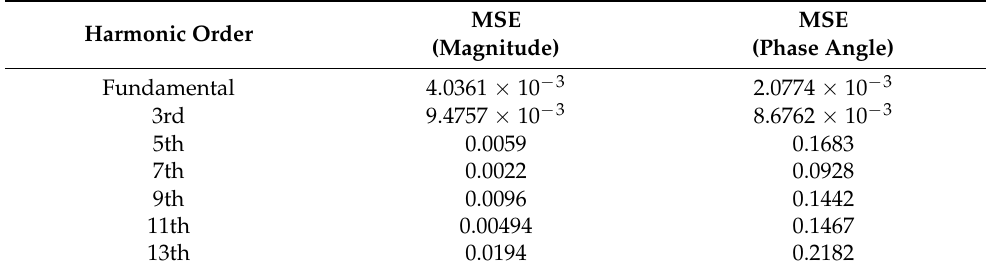
Table 2. MSE values of the